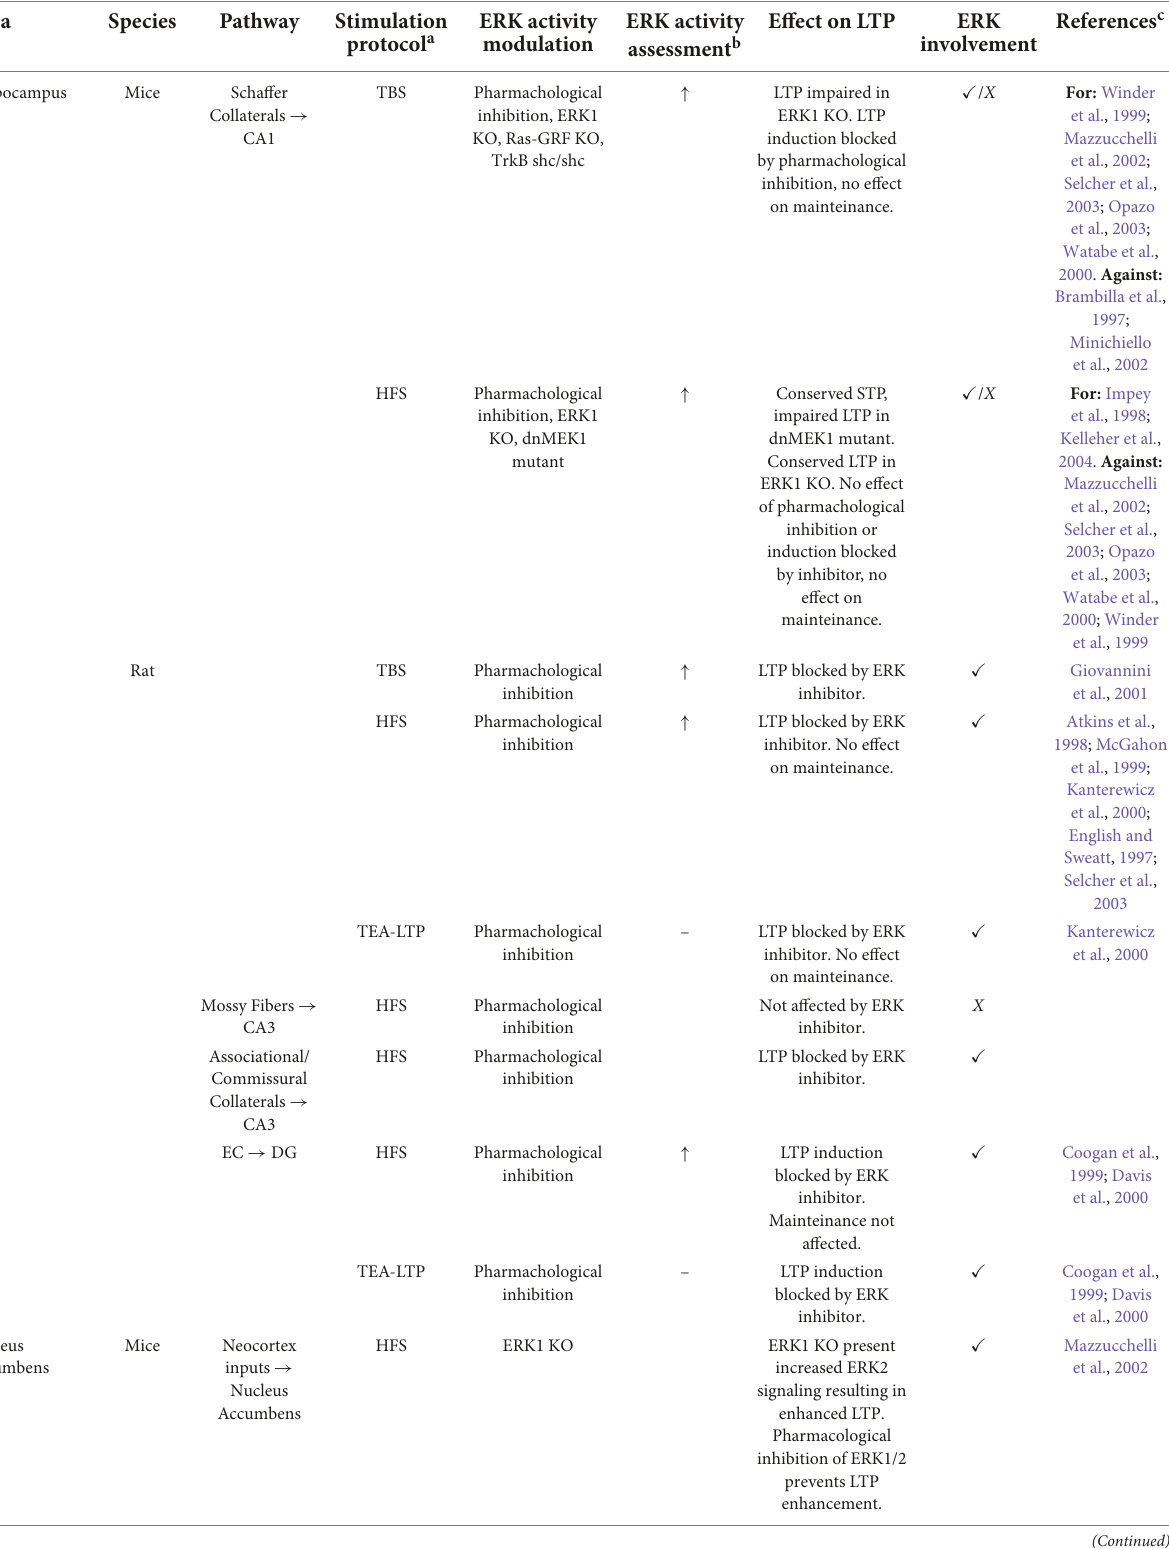
TABLE 1 Summary of evidence linking ERK to different forms of LTP and